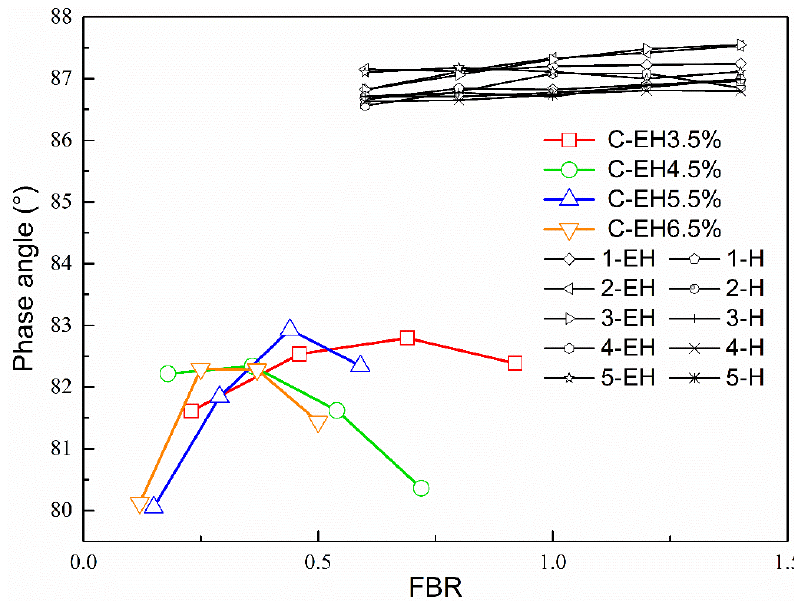
Figure 4. Relationships between mastic phase angles and FBR.